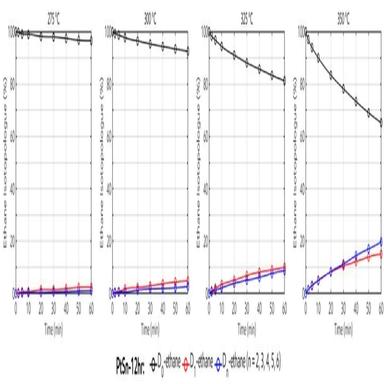
Monitoring H/D exchange between ethane and D2 on PtSn-12hr at selected temperatures. C2H6 (black), C2H5D (red), sum of C2H4D2, C2H3D3, C2H2D4, C2HD5 and C2D6 (blue). (For interpretation of the references to colour in this figure legend, the reader is referred to the web version of this article.)